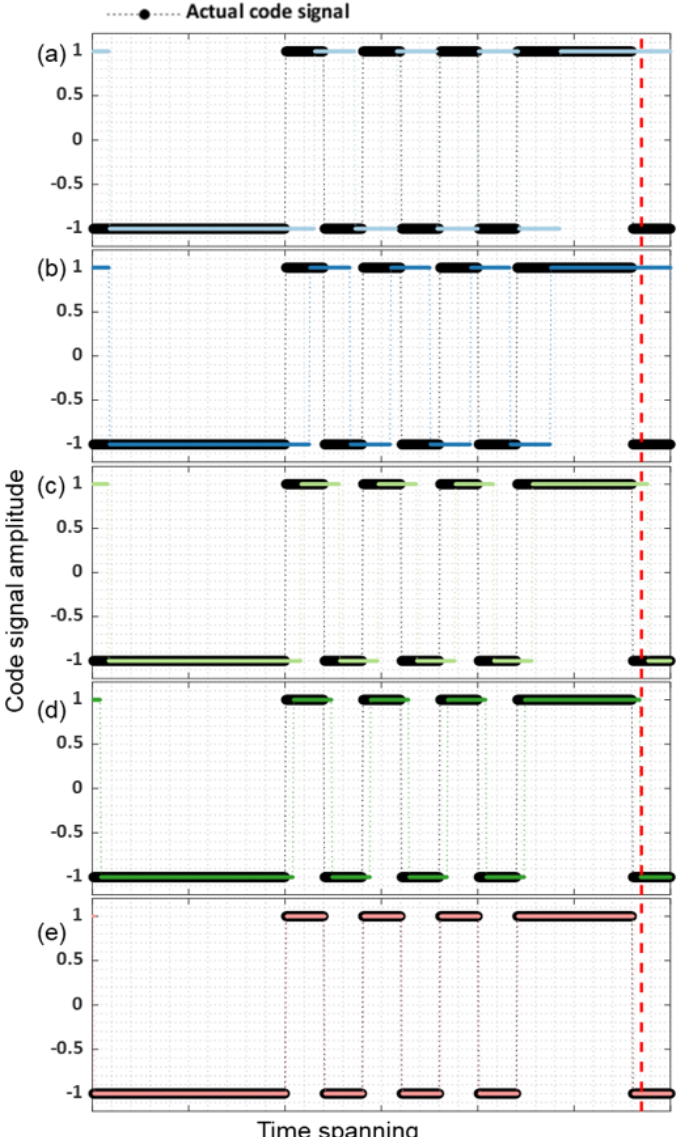
Figure 1. Diagrammatic sketch reflecting the actual, and locally replicated, code signals varying with time regarding different algorithms, where colored curves correspond to the locally replicated code signals. ( a ) code phase misalignment is caused by the code frequency error and the initial (absolute) code phase error, light blue corresponds to the replicated signal based on STL ( b ) moderate frequency error is reduced, deep blue corresponds to the replicated signal based on standalone traditional VT ( c ) significant frequency error is reduced, light green corresponds to the replicated signal based on RTK/INS traditional VT ( d ) significant frequency error and moderate initial code phase error are reduced, deep green corresponds to replicated signal based on RTK VDFPLL ( e ) significant frequency error and significant initial code phase error are reduced, pink corresponds to replicated signal based on proposed RTK/INS VDFPLL. Dashed red lines correspond to